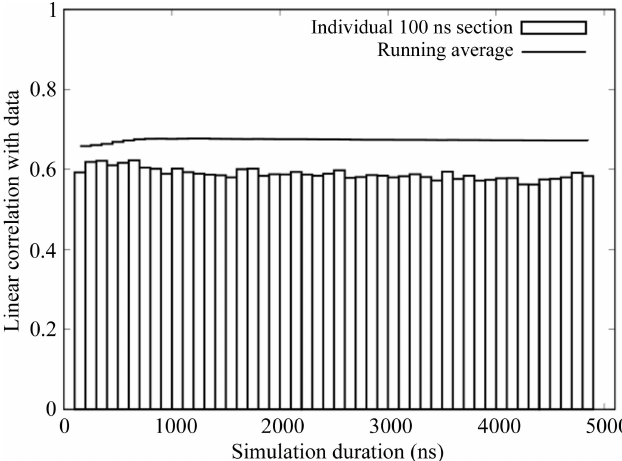
Figure 2 Linear correlation between the simulated and experimental diffuse intensity evaluated for sequential 100 ns sections of the MD trajectory (dashed boxes) and as a running average (solid line). The running average reaches a maximum at a value of 0.68 within the first